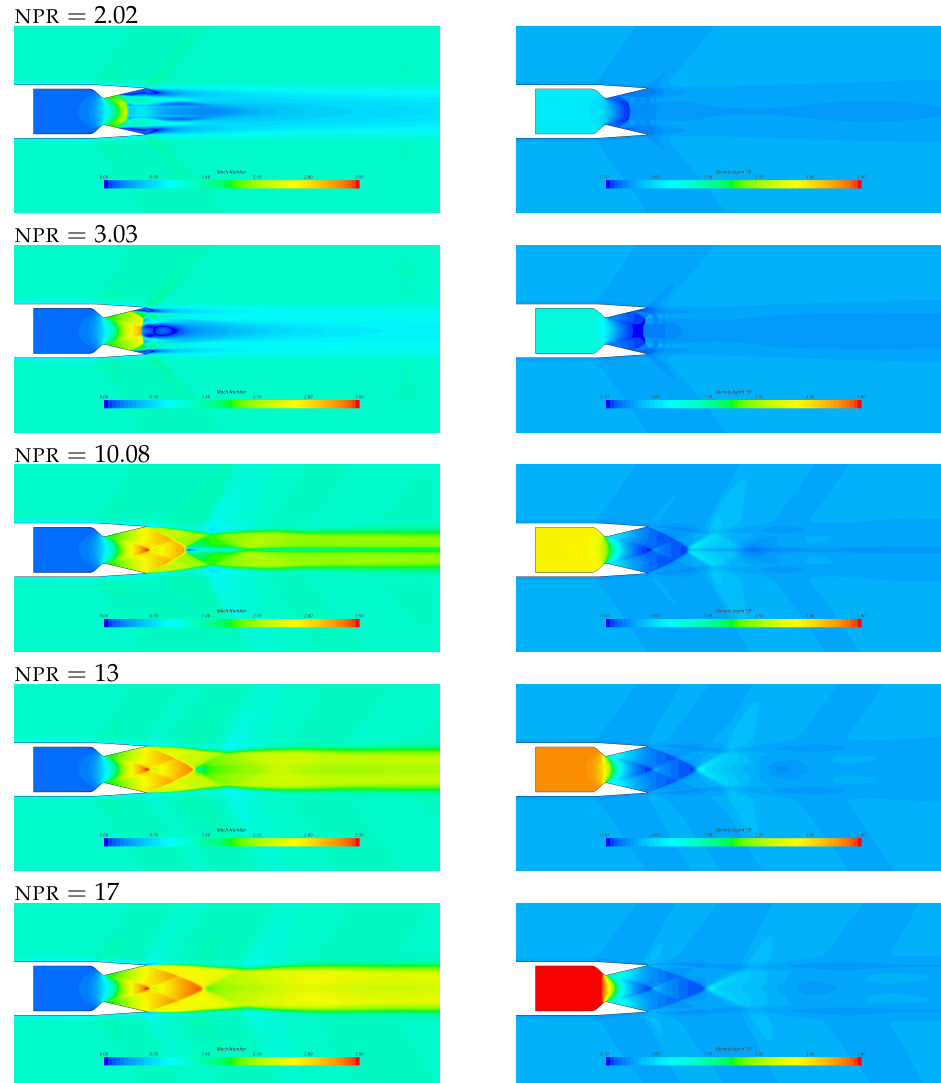
Figure 8. Mach number ( left ) and density ( right ) fields for different NPR ’s and M ∞ = 1.2. As can be seen in Figure 11, the recession of the injection slot position moves the first oblique shock backwards, and expands the separated flow region near the slot. When the opening position is too far upstream a reattachment of the flow can be seen for this value of the mass flux per unit area, however this problem is eliminated when either the injection area is restricted or the mass flux per unit area is increased, or both. A comparison between the perturbation of the main flow in axisymmetric conditions and in three dimensions, for the same position of the slot and the same value of mass flux is shown in Figure 12. The chosen mass flux for the comparison is that corresponding to a secondary injection of 6% of total mass flow rate in the three dimensional case. The increase in value of the mass flux eliminates the aforementioned problem of reattachment of the flow for the axisymmetric case and, as can be seen in the figure, the effect of the injection in these conditions is more pronounced than that in the three dimensional case. With these considerations in mind, the slot position at 70% of the nozzle length has been considered the most adequate for the purposes of the subsequent three dimensional